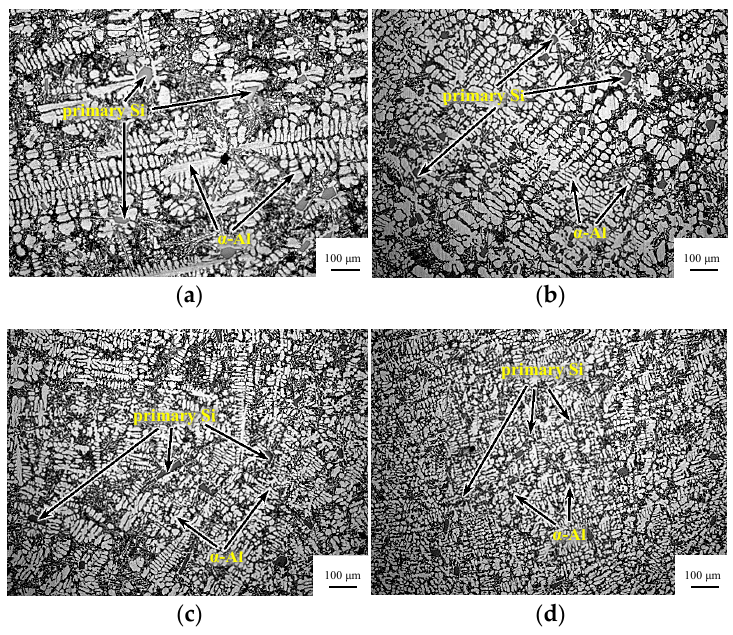
Figure 13. Microstructures in the center of the billet: ( a ) conventional process; ( b ) 100 A; ( c ) 150 A; ( d ) 200 A.